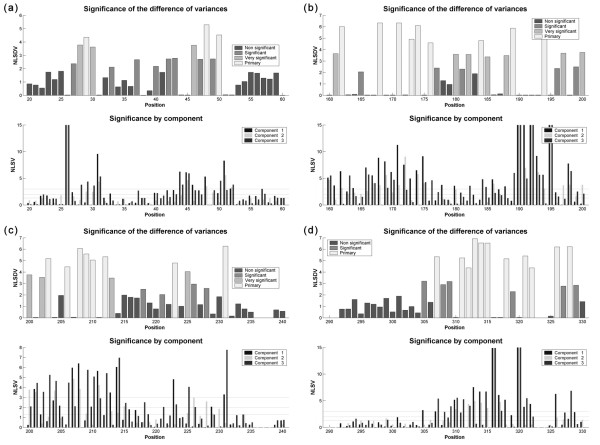
Result plots for the amino acids that form the active site of BglII. Global significance of positions and significances of variances for each component, for positions in the multiple alignment corresponding to amino acids that form the active site of BglII (and other family 16 glycosyl hydrolases): (a) positions 20-60; (b) positions 160-200; (c) positions 200-240; and (d) positions 290-330.